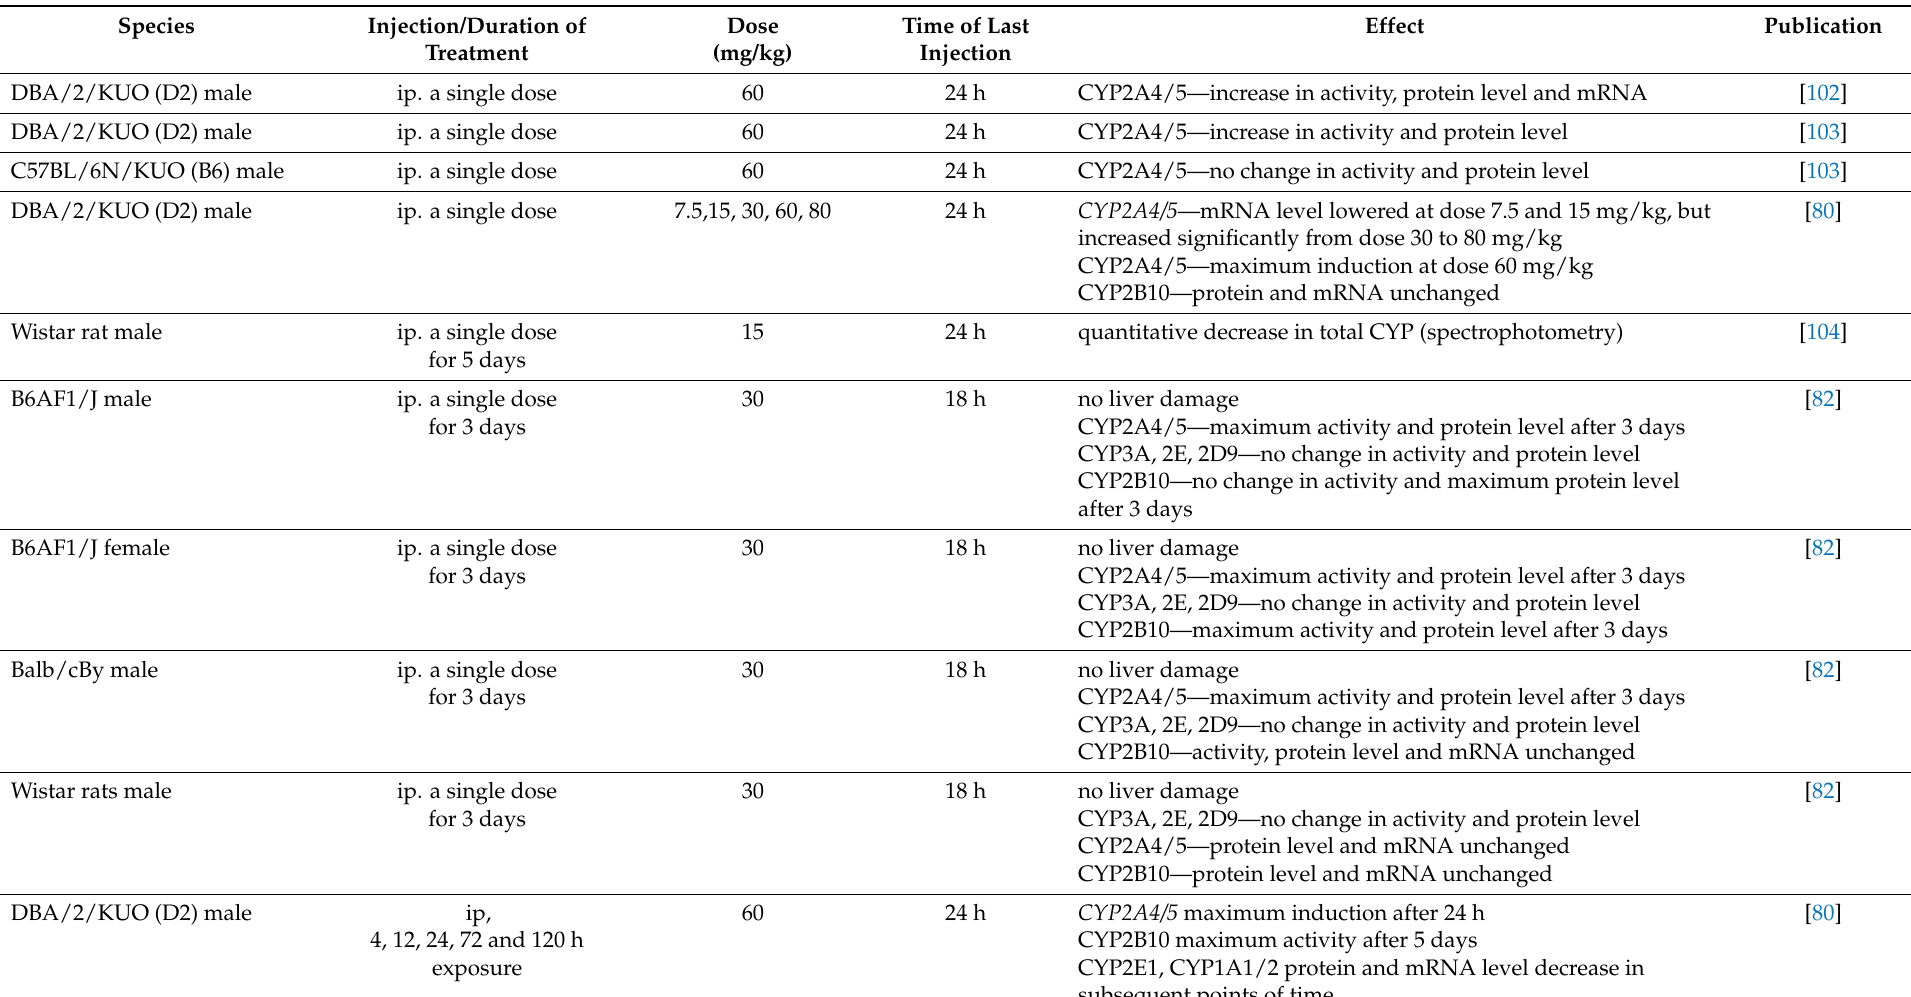
Table 2. Effects of cocaine or combinations of cocaine and CYP inducers on the CYP expression and activity in selected animal species.